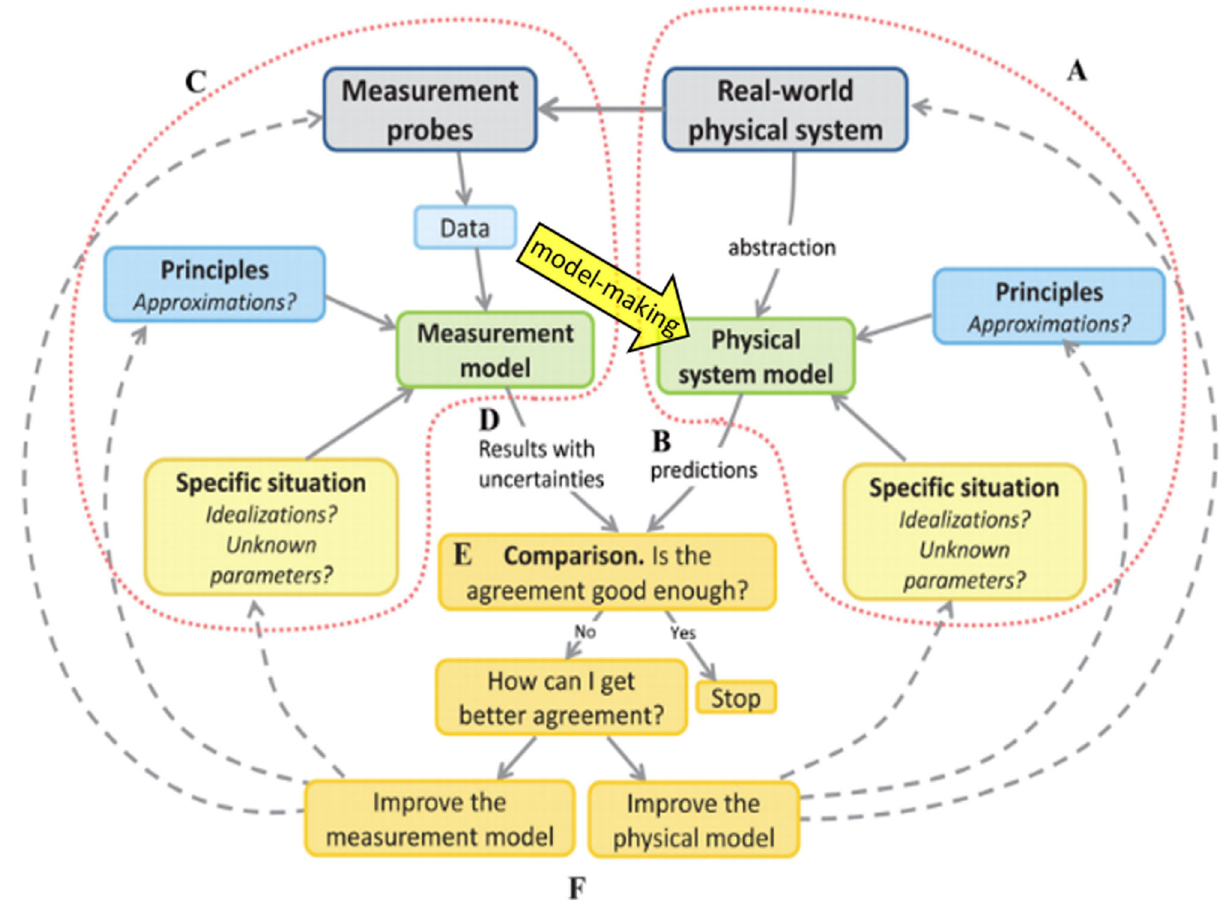
FIG. 2. This graphic is a slightly modified version of a figure from Zwickl, Finkelstein, and Lewandowski ’ s paper on modeling [36]. The diagram does an excellent job of concisely representing the steps in the process of modeling in science. Within this framework, model breaking is represented as a sequence of steps that begins with Data (upper left) and ends at stage E. Note: for this work we did not emphasize the intermediate step “ measurement model ” which appears in that sequence of steps. Our conception of model-making (going from data to a physical system model) did not appear as a transition in the original graph, so the diagram was modified by the addition of the yellow “ model-making ” arrow. It should be noted that a modified version of the diagram has recently been published [1], and further modifications are in process [private communication]. Here is the figure ’ s original caption: A framework for modeling in a physics laboratory involving (A) construction of a model of a real-world physical process, (B) making predictions about the behavior of the physical system, (C) creating a model of measurement tools, (D) using the measurement model to interpret the data and understand the limitations of measurements, (E) make comparisons between the data and predictions, and (F) model refinement